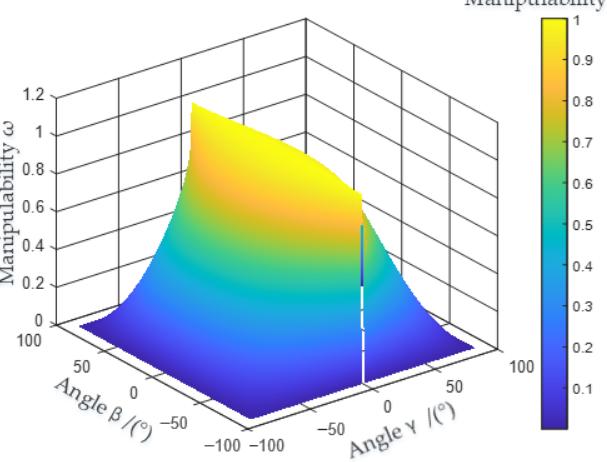
ω values in − 90°~90°.